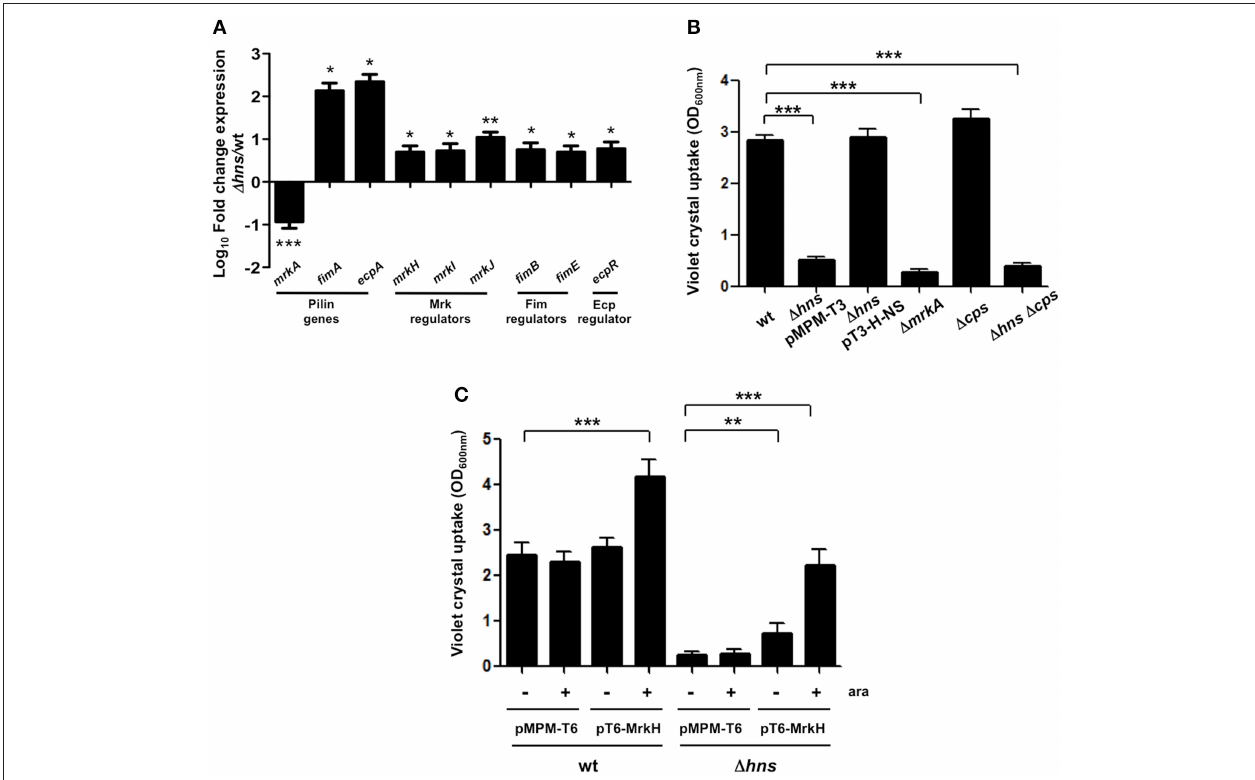
FIGURE 2 | H-NS positively regulates mrkA expression. (A) Fold-change expression (qRT-PCR) of the pilin genes and their regulators in the 1 hns mutant as compared to the K . pneumoniae wild-type strain. (B) Quantification of biofilm formation by measuring Crystal Violet uptake. (C) Quantification of biofilm formation by measuring Crystal Violet uptake overexpressing the MrkH activator protein (0.1% arabinose) in both wild-type and hns background. Results shown represent mean and standard deviations of 3 independent experiments performed. ns, not significant; statistically significant with respect to the wild-type strain *** p < 0.001 ; ** p < 0.01 ; * p < 0.05